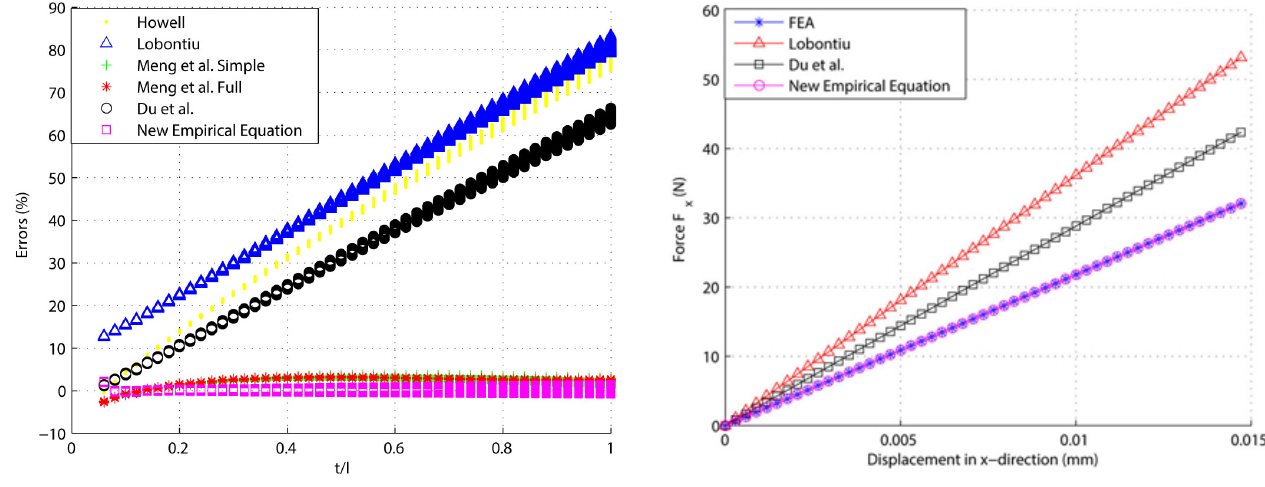
Figure 14. Comparison between FEA results and sti ff ness equa- tions results t / l = 0 .